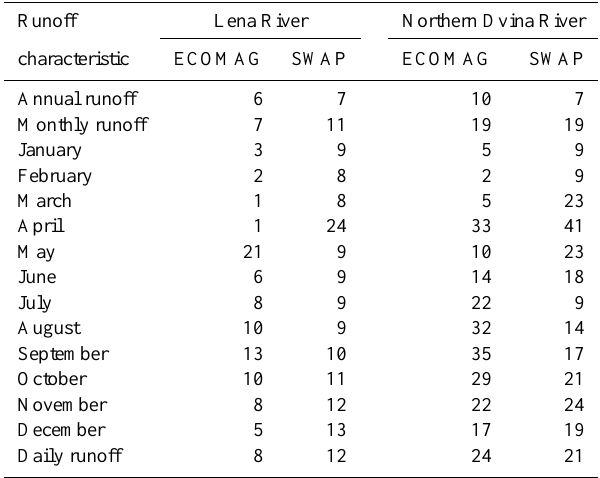
Table 2. Uncertainty indices UN( M ) (in %) for M estimates of an- nual, monthly and daily